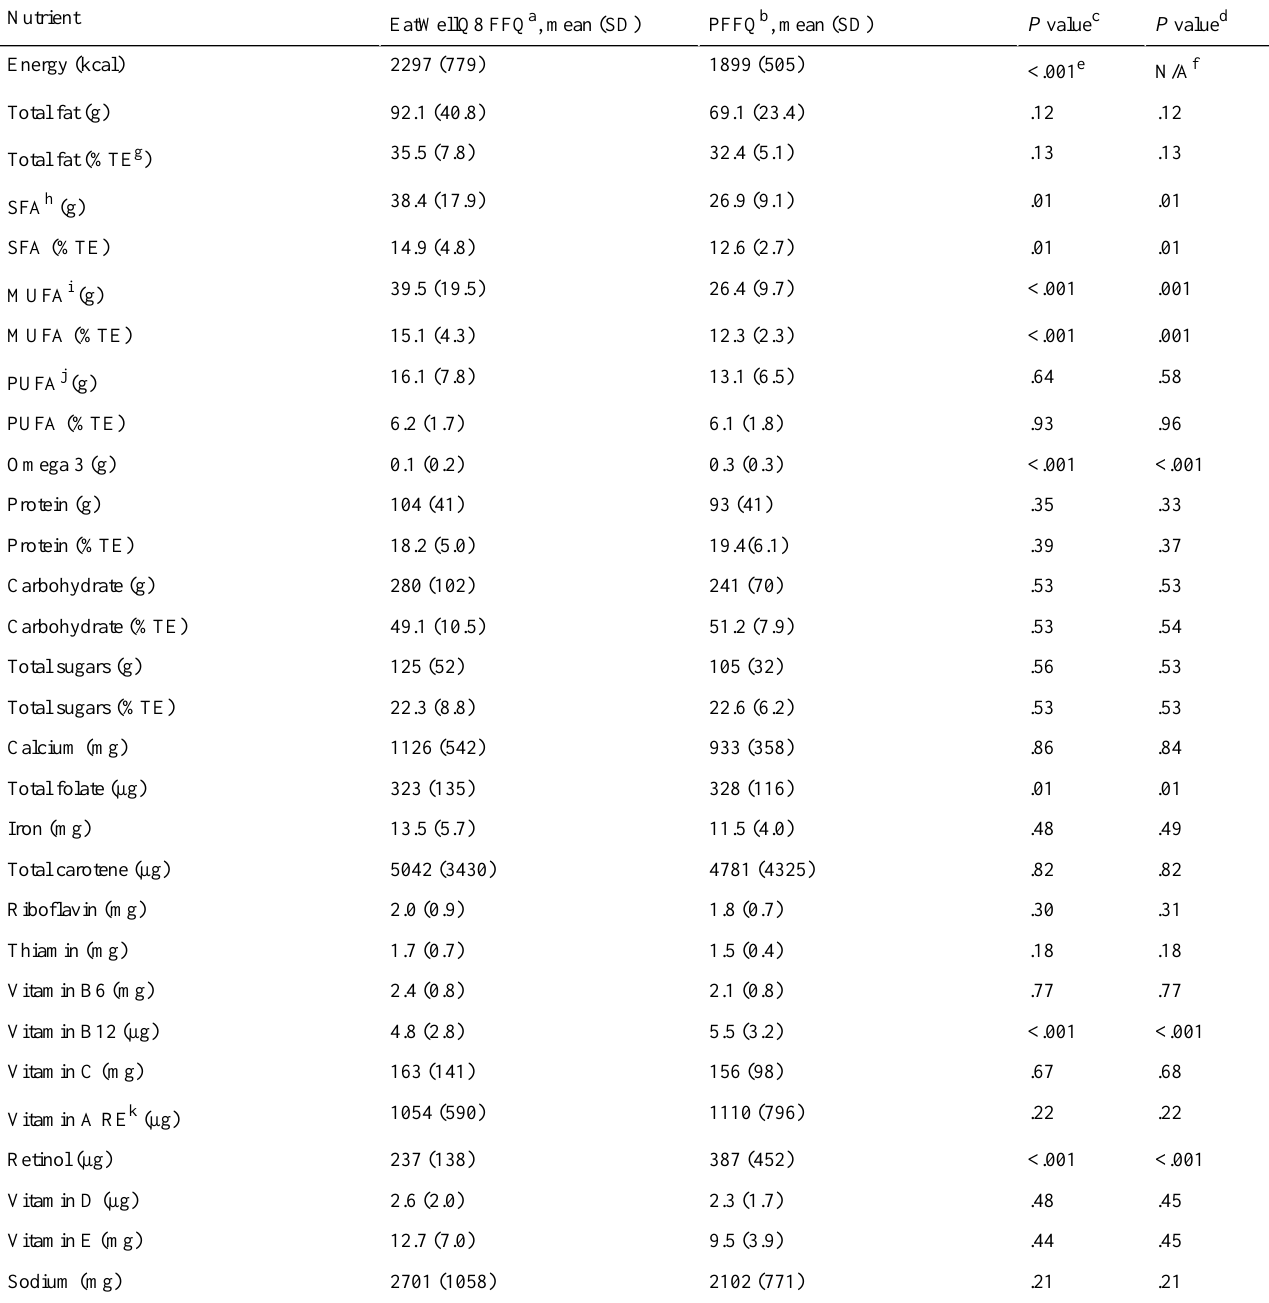
Table 3. Mean daily energy and nutrient intakes estimated by the web-based EatWellQ8 food frequency questionnaire and a paper-based food frequency questionnaire and general linear model results